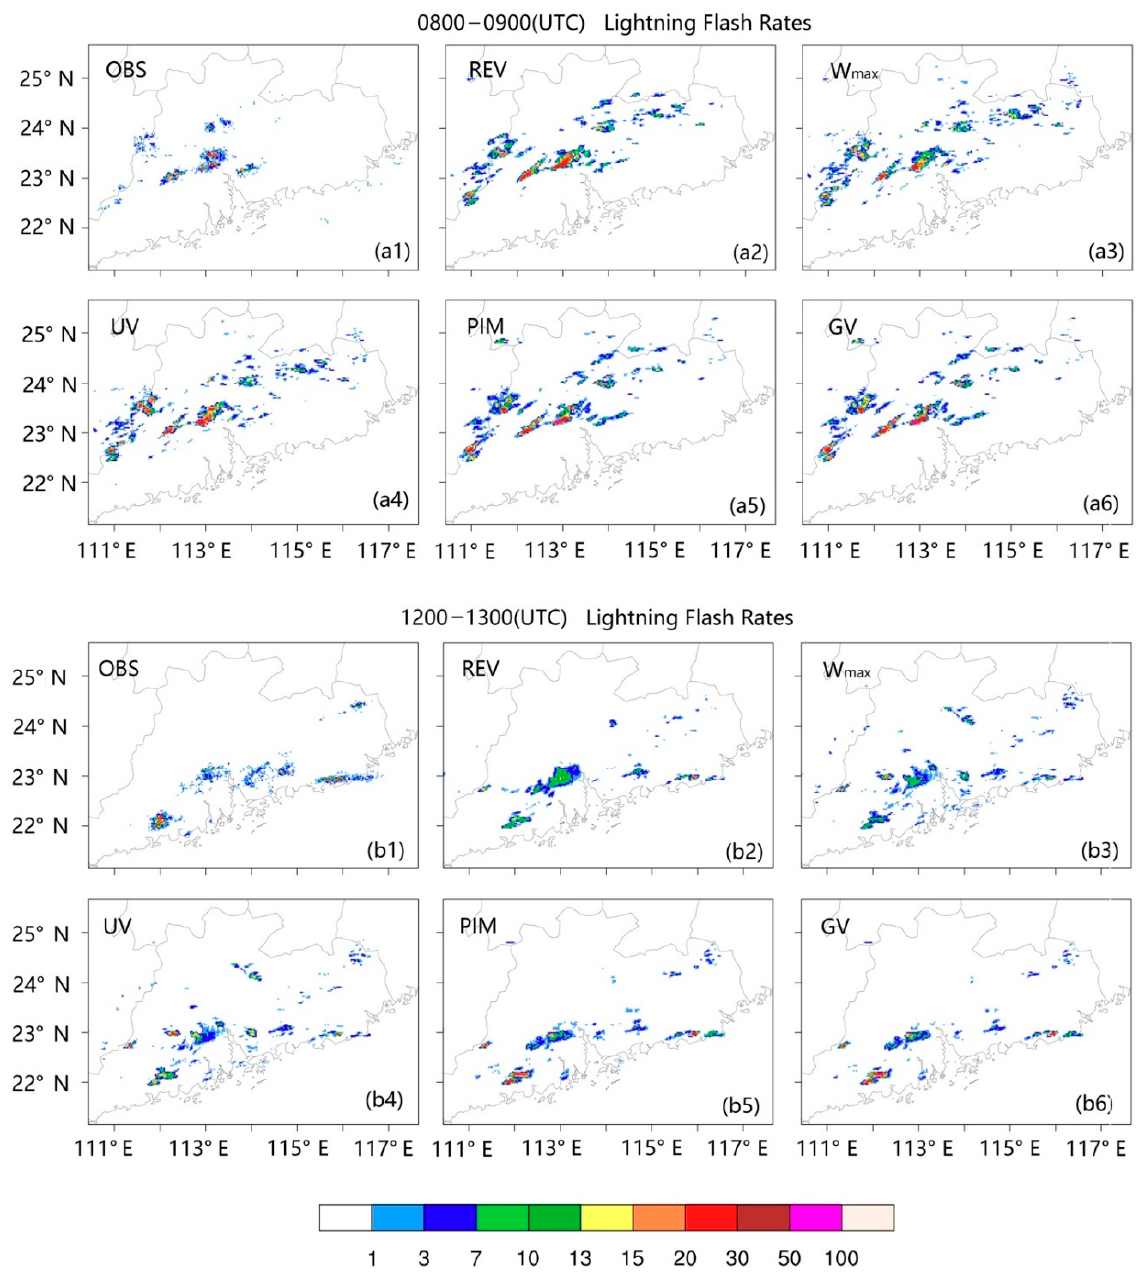
Figure 5. As in Figure 4, but accumulated over two 60 min periods. ( a1 , b1 ) are from the observations, and ( a2 – a6 ), ( b2 – b6 ) are from the different lightning diagnostic schemes with different proxies. The abbreviations of each lightning diagnostic scheme are labeled in each